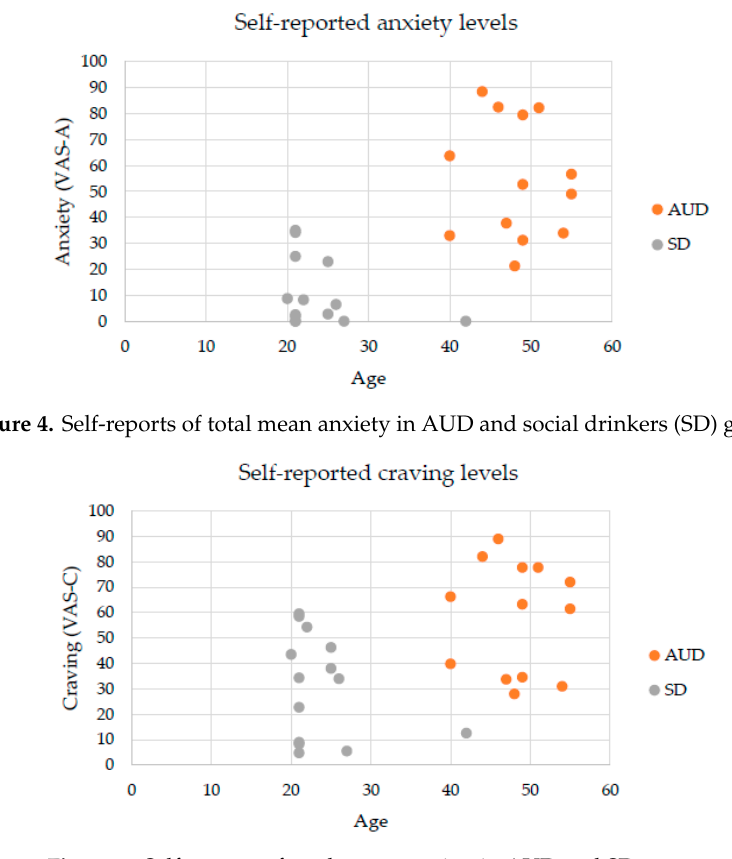
Figure 5. Self-reports of total mean craving in AUD and SD groups.